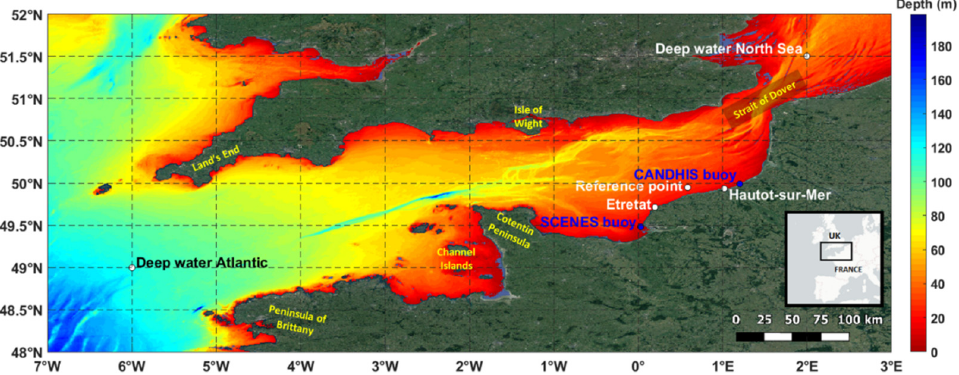
Figure 1. Bathymetry map of the English Channel with the locations of the study sites (Etretat and Hautot-sur-Mer) the two buoys used for validation (in blue), the two points located in deep waters (North Sea and Atlantic Ocean) and the Reference point in intermediate waters. The latter three were used for studying the transformation of waves when getting inside the Channel and when approaching the study sites. Main geographical features are highlighted in yellow.